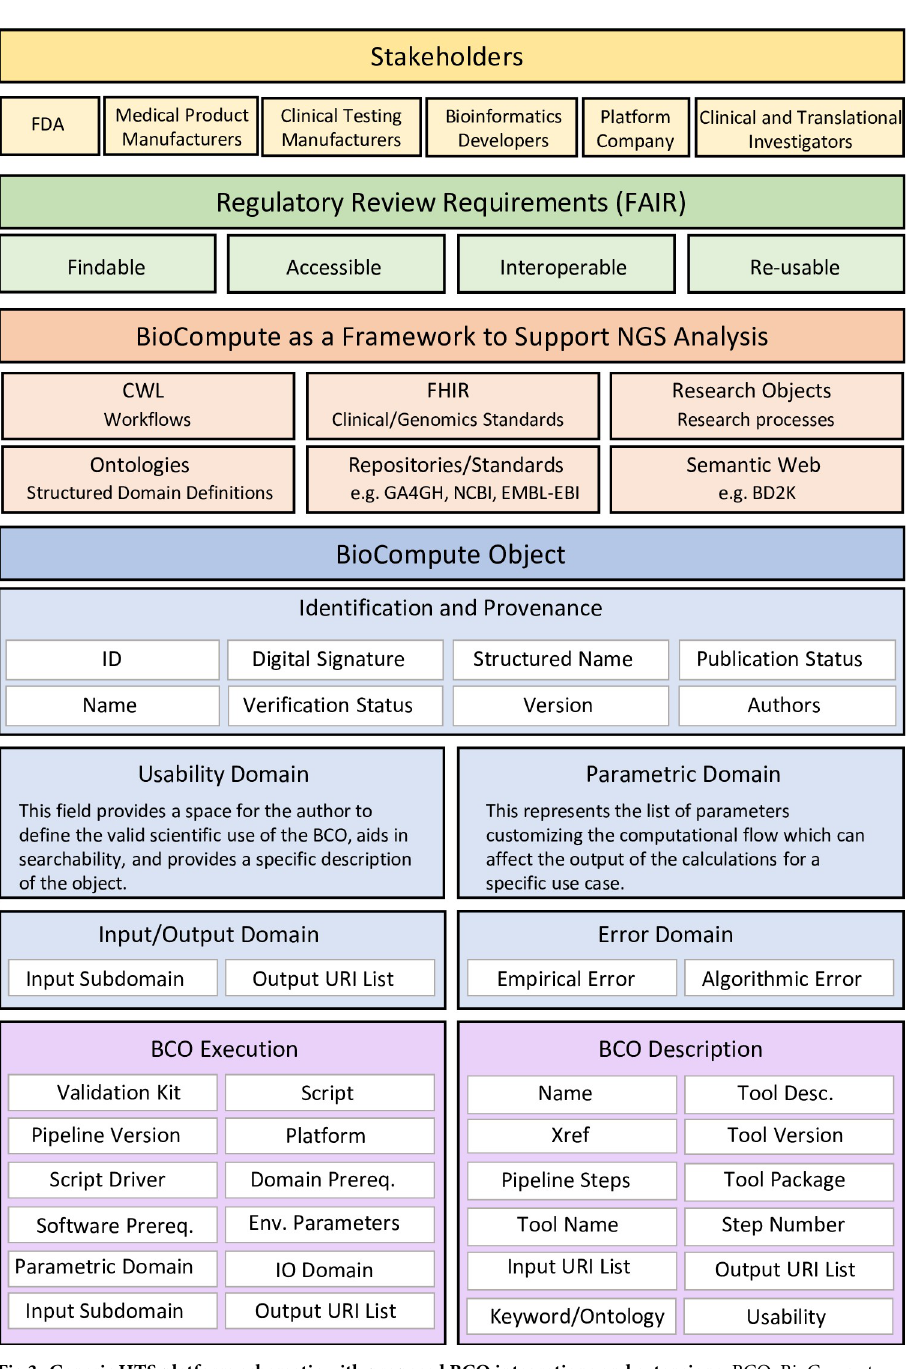
Fig 3. Generic HTS platform schematic with proposed BCO integrations and extensions. BCO, BioCompute Object; BD2K, Big Data to Knowledge; Desc., description; EMBL-EBI, European Molecular Biology Laboratory- European Bioinformatics Institute; Env., environmental; FDA, Food and Drug Administration; FHIR, Fast Healthcare Interoperability Research; GA4GH, Global Alliance for Genomics and Health; ID, identification; IO, input/output; NCBI, National Center for Biotechnology Information; NGS, Next-Generation Sequencing; Prereq., prerequisite; PROV, provenance specification; RO, research object; URI, uniform resource identifier; W3C, World Wide Web Consortium; Xref, external